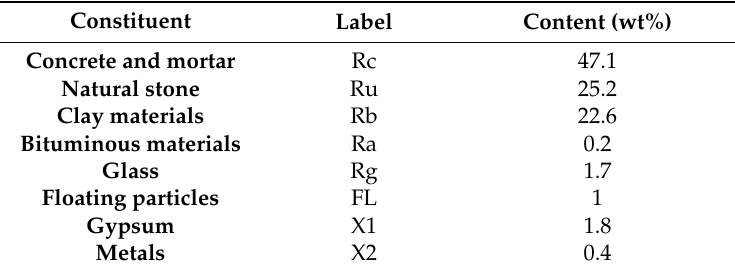
Table 3. Composition of the source concrete.